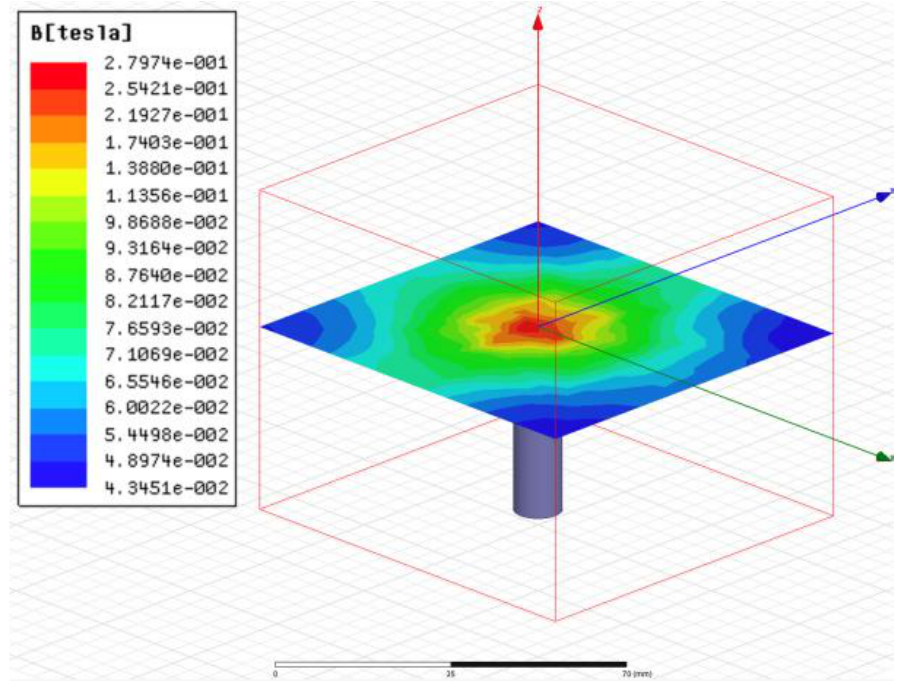
Figure 7. Cloud image of magnetic field intensity.